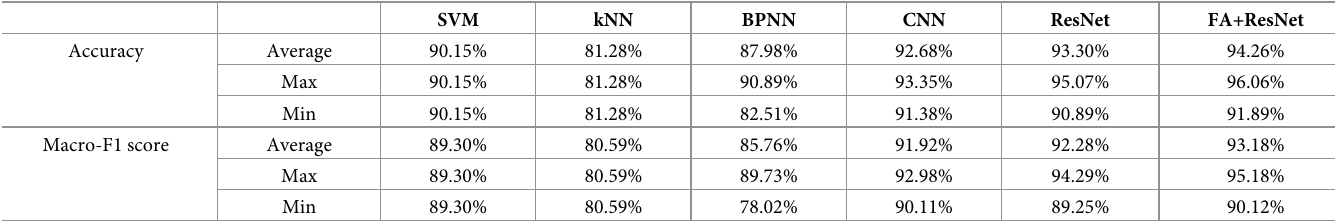
Table 4. Accuracy and Macro-F1 score of SVM, kNN, BPNN, CNN, ResNet, FA+ResNet models in predicting suitable areas for premium teas. SVM kNN BPNN CNN ResNet